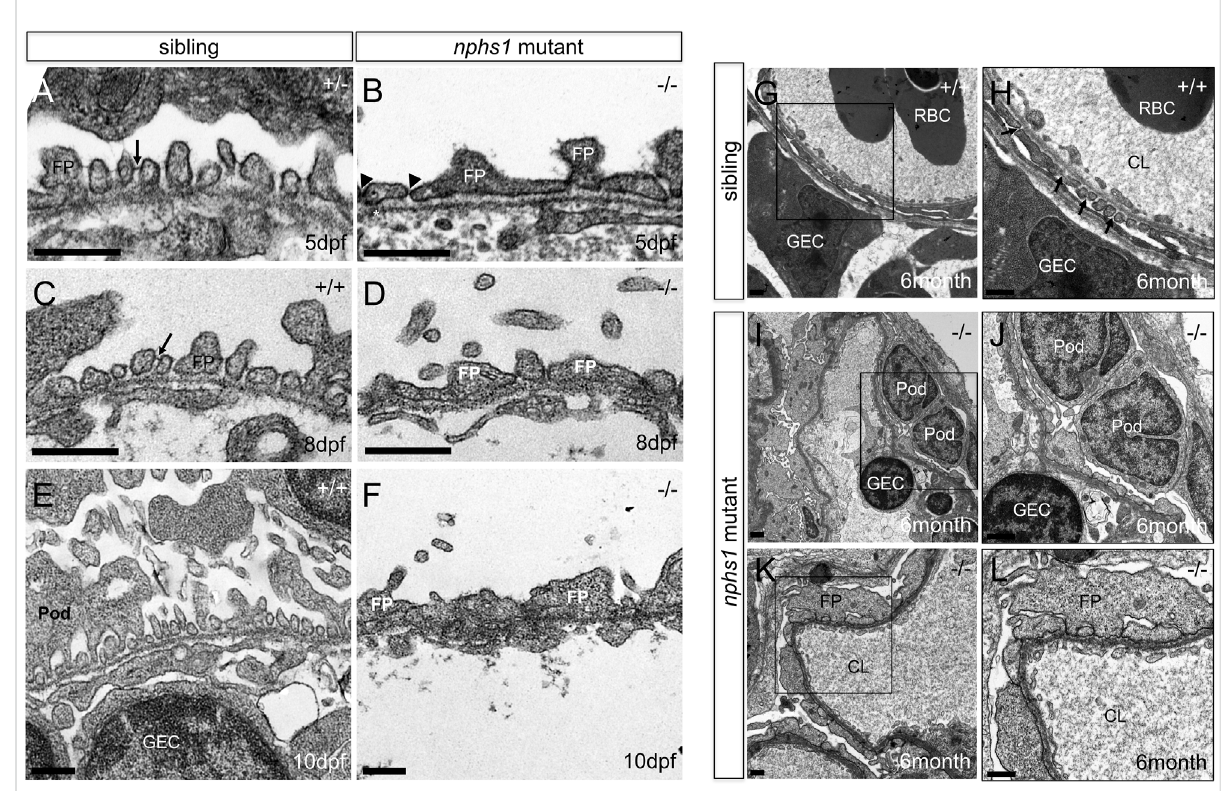
Lack of nephrin results in absence of slit-diaphragms and foot process effacement. (A,C,E) Transmission Electron Micrographs (TEM) of the podocytes foot processes inwildtypezebra fi shat5, 8,10dpf.Presence ofslit diaphragms aremarked witharrows. (B,D,F) TEMofthepodocyte foot processes in nphs1-/- at 5, 8, 10 dpf showing widened and irregular foot processes effacement with lack of detectable slit diaphragms (arrowheads) (Scale bar, 400 nm). (G – H) TEM of the mesonephric podocytes foot processes in 6-month-old adult wild-type siblings. Presence of slit diaphragms are marked with arrows. (I – L) TEM of the mesonephric podocytes foot processes in viable nphs1-/- adults. The foot processes are effaced and widened with absence of slit diaphragm throughout capillary wall in 6-month-old adult nphs1 mutants. (H,J,L) Higher-magni fi cation images show podocyte foot-process effacement in nphs1-/- adults. Pod: podocyte; FP: foot process, GEC: glomerular endothelial cells; CL: glomerular capillary lumen; RBC: red blood